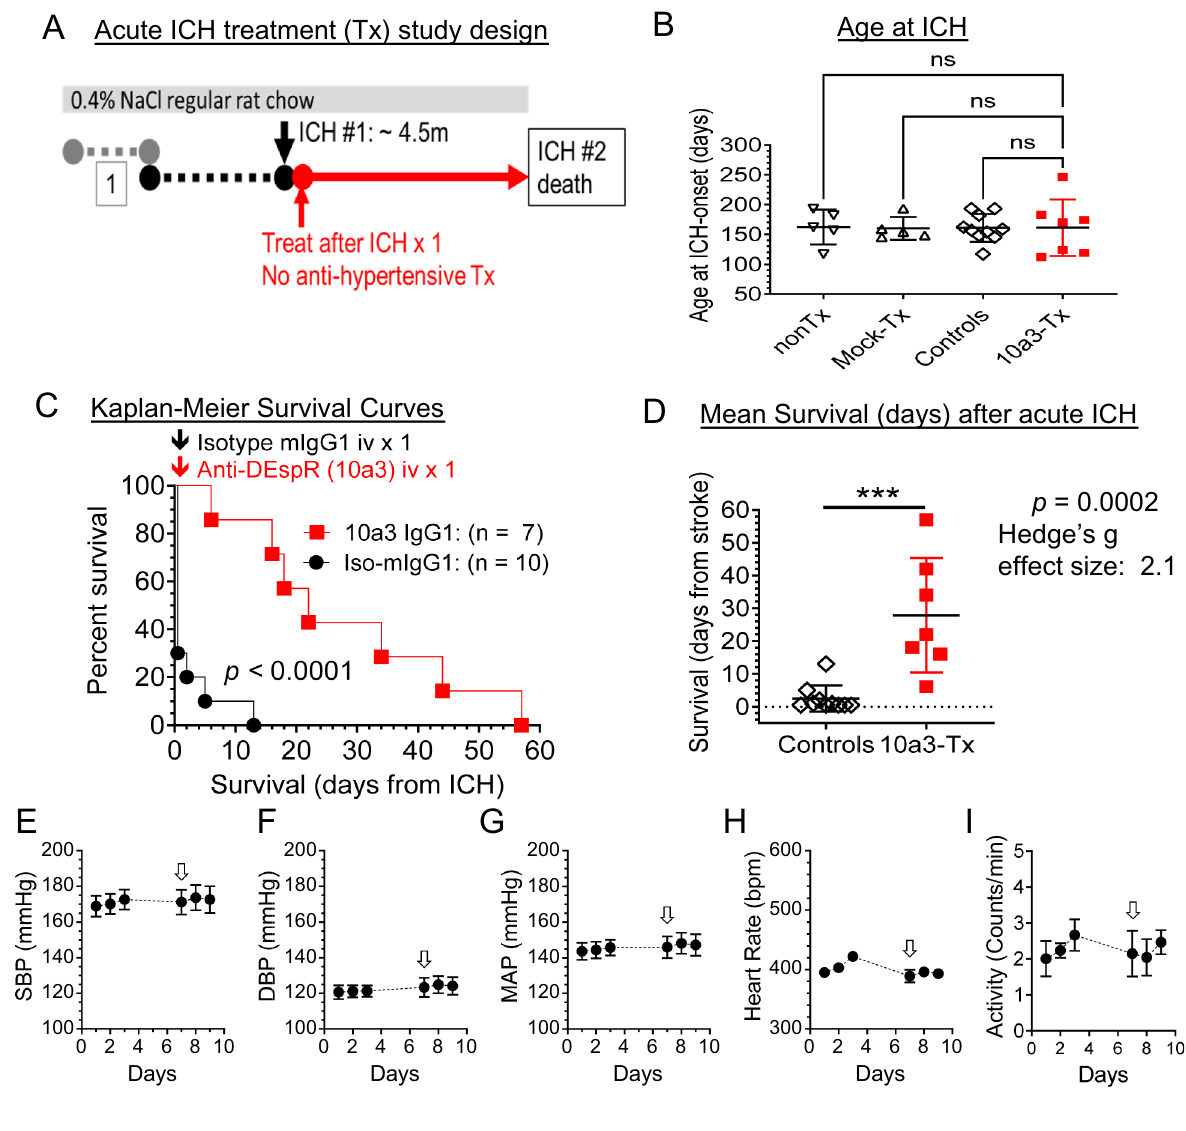
Figure 3. Preclinical efficacy testing of single-dose anti-DEspR murine mAb prototype, 10a3, at acute sICH. ( A ) Diagram of experimental design of onset of treatment (anti-DEspR mAb 10a3, 50 μg/kg/dose × 1) or mock treatment (isotype murine IgG1, 50 μg/kg/dose × 1) given after first ICH (#1) documented. Monitoring until the 2nd stroke with SBP remaining at ≥ 200 mmHg; no anti-hypertensive therapy given. ( B ) Graph of age at onset of sICH among study groups: treated rats (n = 7), total control group (n = 10), made up of non- treated (nonTx, n = 5) and muIgG1-isotype (mock-Tx, n = 5). Kruskall Wallis ANOVA on ranks and Dunn’s multiple pairwise comparison were not-significant. ( C ) Kaplan–Meier Survival curves comparing treated (n = 7) and all control (n = 10) hsICH rats: median overall survival (Control vs Treated: 0.5 vs 22 days); Mantel Cox log-rank test p < 0.0001. Log rank hazard ratio 3.5, (95% CI 1.23–10.05). ( D ) Two-tailed unpaired Mann Whitney rank test of survival to 2nd stroke comparing controls (n = 10), mean ± sd: 2.4 ± 3.96) vs treated (n = 7: 28.9 ± 17.5), ***p = 0.0002 with Hedge’s g effect size [− 4%] = 2.1. ( E – I ) Average 24-h blood pressure and activity measurements obtained via radio-telemetry implant system before and after single-dose anti-DEspR 10a3 treatment ( ↓ ) in naïve 4 m-old Dahl S female rats (n = 6): ( E ) systolic blood pressure, SBP, ( F ) diastolic blood pressure, DPB, ( G ) mean arterial pressure (MAP), ( H ) heart rate, and ( I ) activity (number of times the single- housed rat crosses the midline section of the